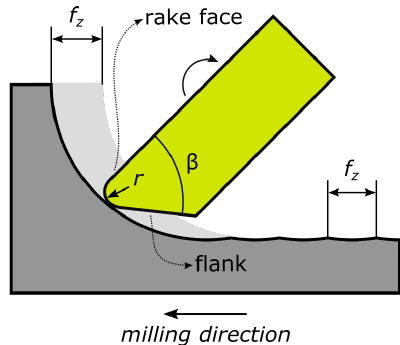
Figure 1. Illustration of the tool parameters wedge angle β and cutting edge radius r along with single tooth feed f z and milling direction.